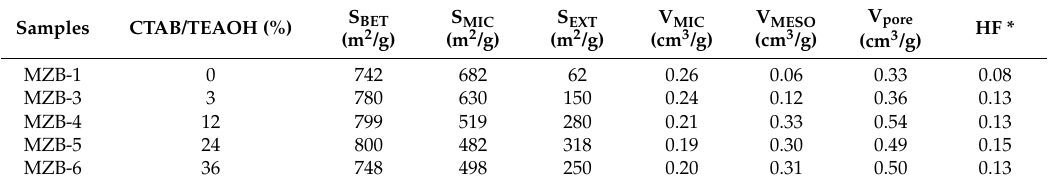
Table 1. Pore structure parameters of hierarchical Beta zeolites with different CTAB amounts.